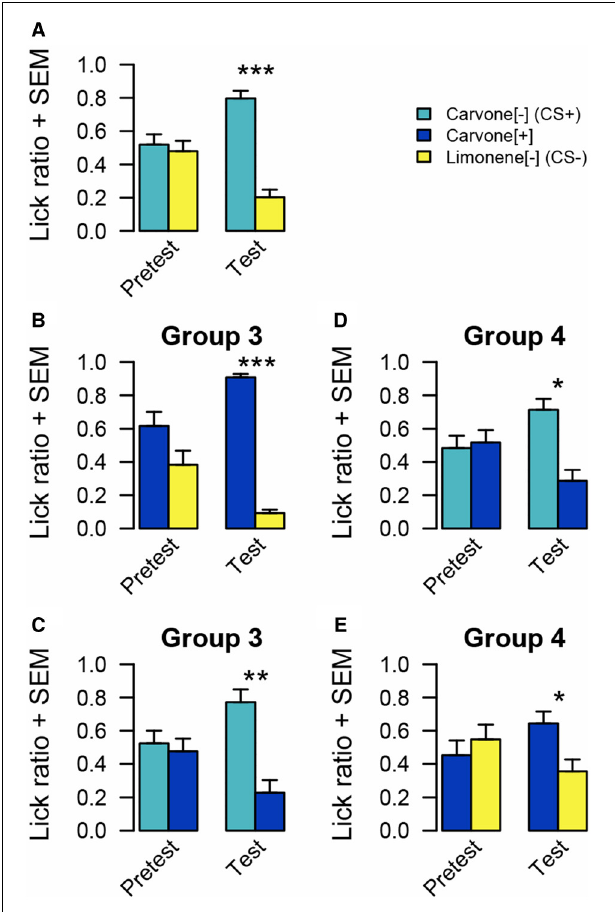
FIGURE 3 | Odor preference measured by lick ratio in experiment 2. (A) For all rats, there is no preference between C[ − ] and L[ − ] before conditioning. After conditioning, animals preferred C[ − ]. (B) For group 3, there is no significant difference between C[ + ] and L[ − ] before conditioning. After conditioning, rats preferred C[ + ]. (C) For group 3, there is no preference before conditioning between C[ − ] and C[ + ]. After conditioning, animals preferred C[ − ]. (D) For group 4, there is no odor preference between C[ − ] and C[ + ] before conditioning. After conditioning, rats preferred C[ − ]. (E) Before conditioning, rats of group 4 have no preference between C[ + ] and L[ − ]. After conditioning, they preferred C[ + ]. Data are presented as means of ratio (number of licks for the bottle on the sum of the number of licks for the two bottles) + s.e.m over the